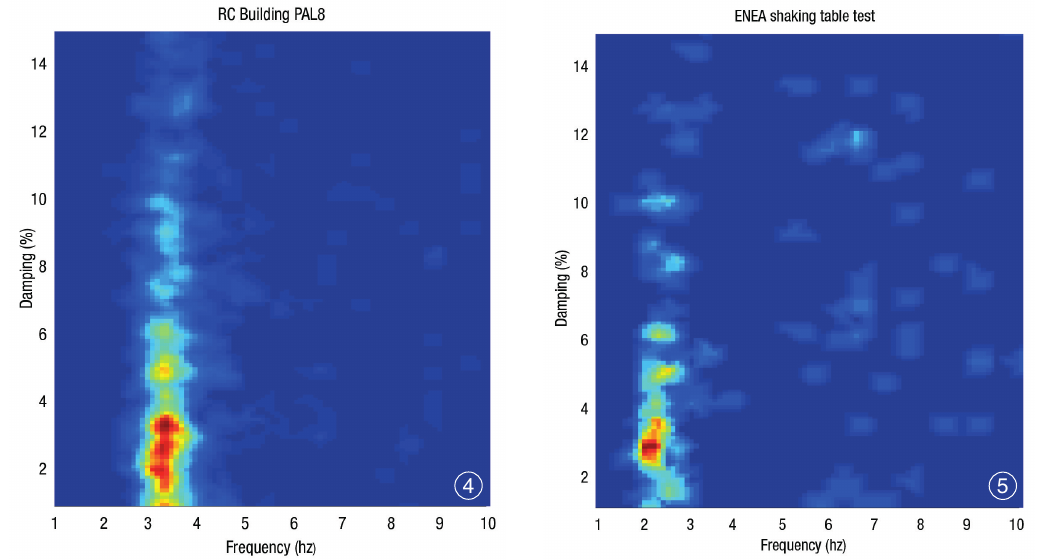
Fig. 4. NonPaDAn estimate of frequency and damping for a R.C. building (PAL8 in Di Giulio et al ., 2004). Fig. 5. NonPaDAn estimate of frequency and damping for a scale model tested with random vibration at the ENEA Casaccia shaking table